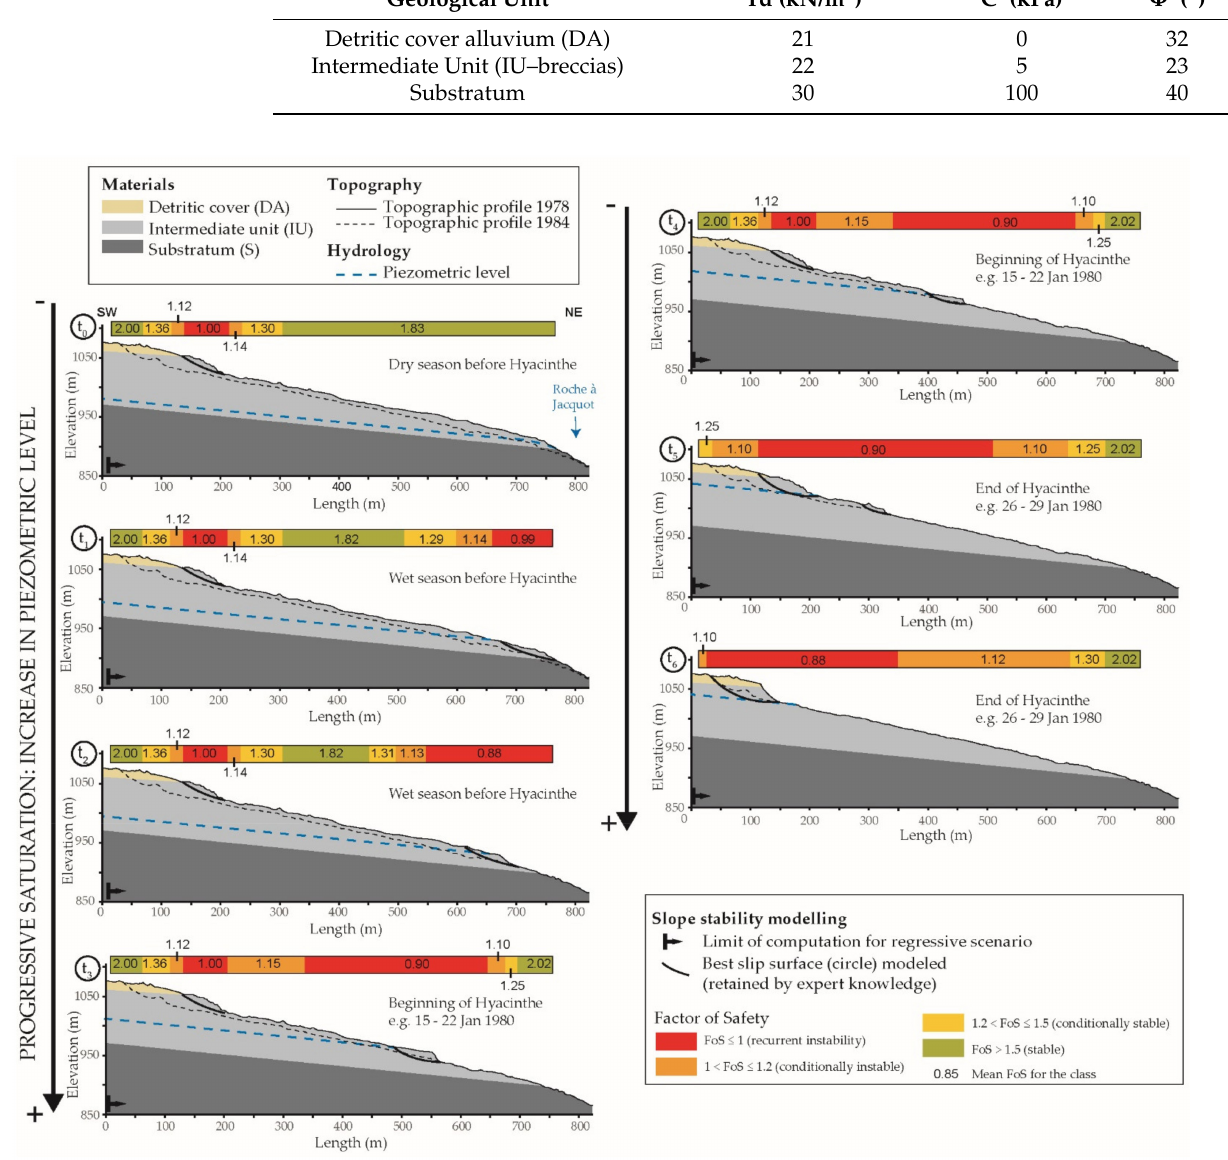
Figure 8. Headward retreat simulations. Scenarios t 0 to t 6 show the impact of the rise in groundwater level on slope stability (see text for more explanations). The mean values of FoS in the area delineated by coloured rectangles are given. Under dry conditions, the slope is stable except along the upper scarp. By increasing the groundwater level, successive retrogressive failures occur up to the current head of the gully. The values of geotechnical parameters used are in Table